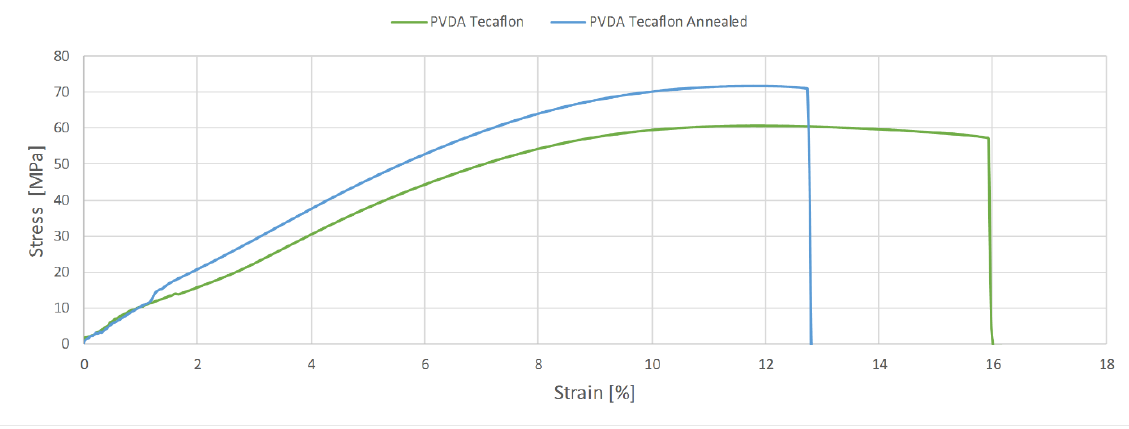
Figure 11. Diagram of the relationship between tensile strength and elongation for PVDA Tecaflon and PVDA Tecaflon after heat treatment. Table 3. Tensile strength test